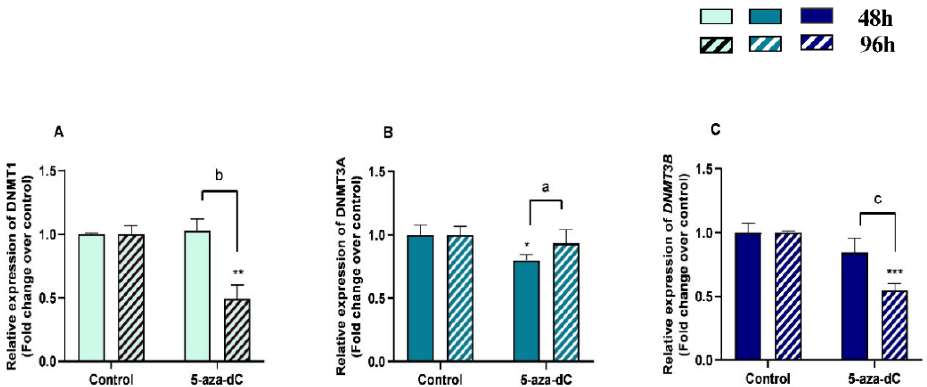
Figure 7. Relative DNA methyltransferases ( A — DNMT1 , B — DNMT3A , and C — DNMT3B ) mRNA levels in mare endometrial fibroblasts after incubation with 5-aza-dC (1 µ M) for 48 h and 96 h; n = 5. All values are expressed as percentage of change from respective hour control (non-treated fibroblasts). Bars represent mean ± SEM. Asterisks indicate significant differences from the respective control (* p < 0.05, ** p < 0.01, *** p < 0.001). a, b, and c letters indicate significant differences between treatment hours (a— p < 0.05; b— p < 0.01; c— p <